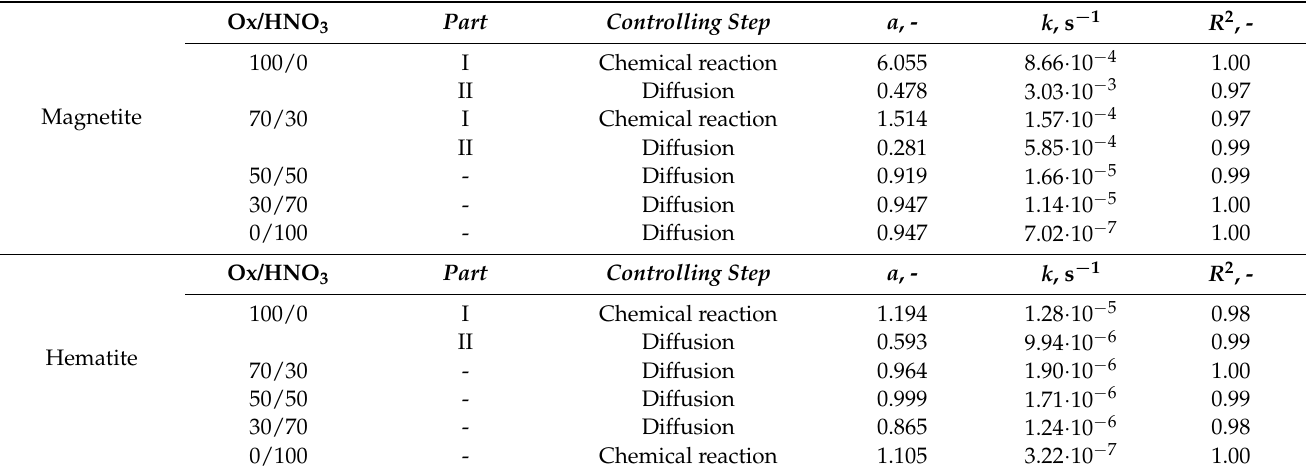
Table 3. Parameters of the Kabai model for different acid ratios. I represents the first linear fit, whereas II represents the second linear fit. The experiments were carried out at 35 ◦